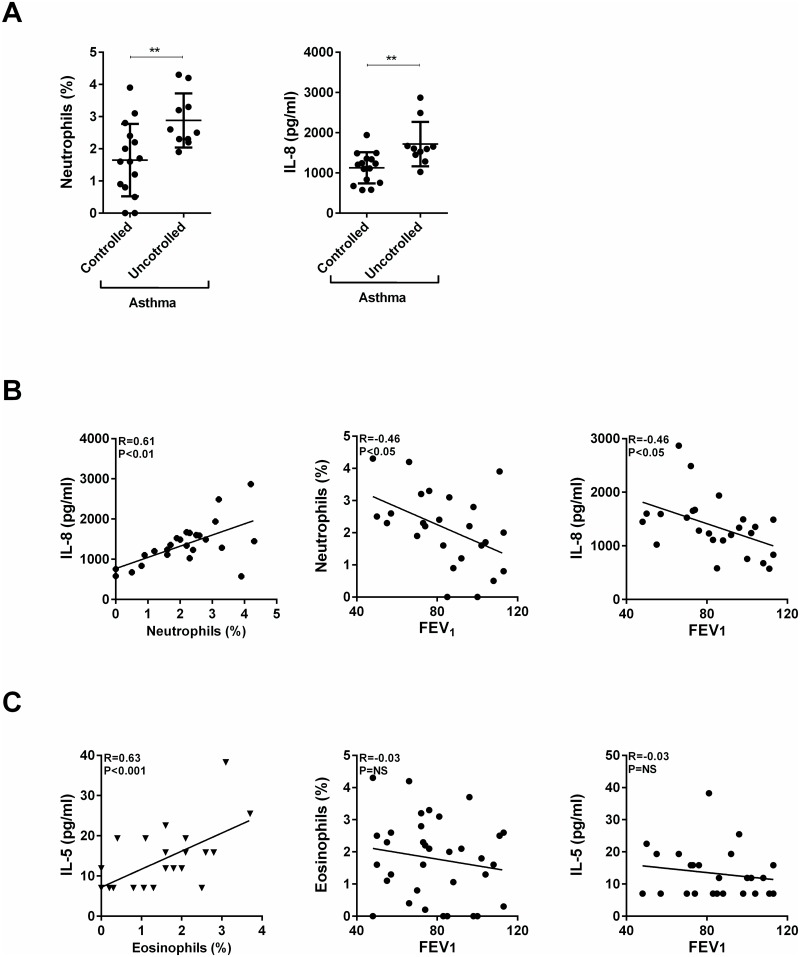
Correlation of FEV1 to eosinophil, neutrophil, IL-5 and IL-8 levels in asthma.(A) Percentages of neutrophils and concentrations of IL-8 in BAL fluids of subjects with controlled asthma and uncontrolled asthma. (B) Correlations of concentrations of IL-8 with the percentages of neutrophils in the BAL fluid from all subjects with asthma (left panel). Correlation of percentages of neutrophils and concentrations of IL-8 in BAL fluid with percent predicted FEV1 (middle and right panels, respectively). (C) Correlation of concentrations of IL-5 with the percentages of eosinophil in the BAL fluid from all subjects with asthma (left panel). Correlation of percentages of eosinophils and concentrations of IL-5 in BAL fluid with percent predicted FEV1 (middle and right panels, respectively). Data are expressed as means ± SEM. * = P < .05, ** = P < .01, *** = P < .001, **** = P < .0001.